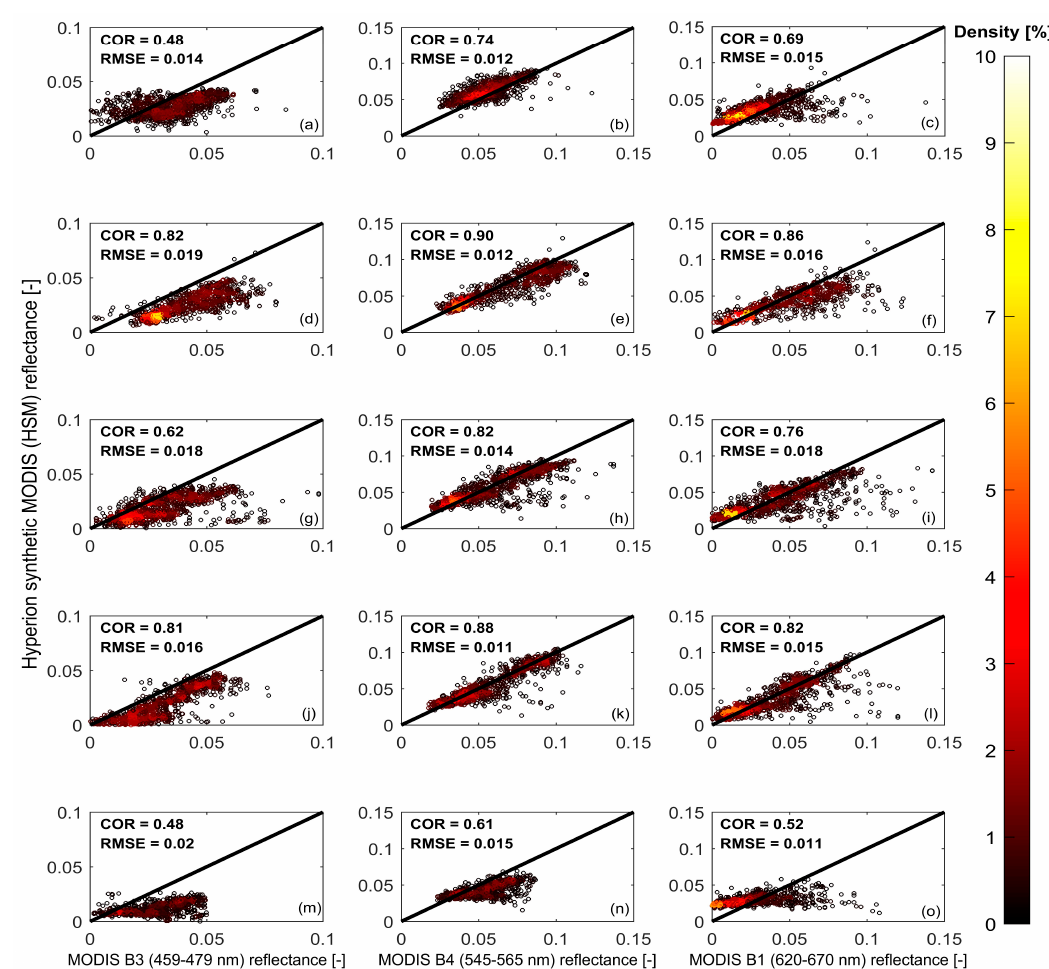
Figure 2. Comparison of reflectance estimated from the moderate-resolution imaging spectroradiometer (MODIS) against the Hyperion Synthetic MODIS (HSM), with data collected on 10 February 2005 ( a – c ), 18 June 2005 ( d – f ), 4 July 2005 ( g – i ), 20 July 2005 ( j – l ), and 7 January 2006 ( m – o ). Colors denote the density (in percentage) of the points, which is estimated as a 2 dimensional histogram using 20 equally spaced bins in both x and y directions. Yellow (black) means a high (low) density of points in a given area of the plot. The Spearman’s rank correlation coefficient (COR) and root-mean-square-error (RMSE) are indicated in each subplot. The p -values for testing the null hypothesis that there is no correlation between the reflectance estimated from MODIS and HSM are all <0.001, suggesting a significant correlation.